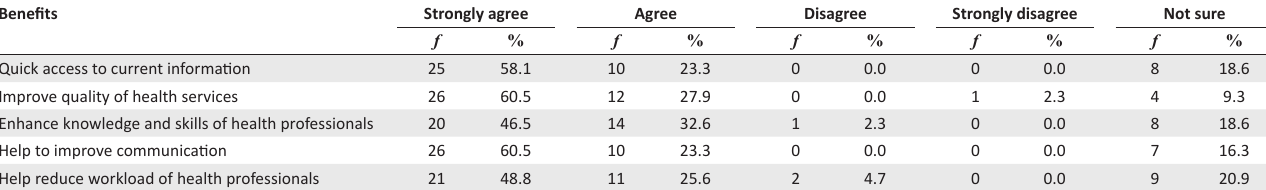
TABLE 4: Benefits of using information and communication technologies in work spaces ( n = 43). Benefits Strongly